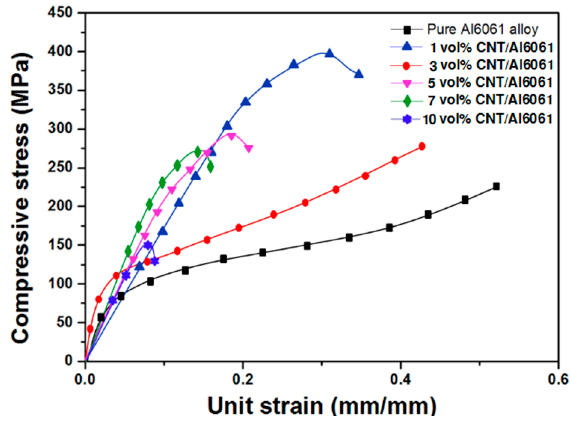
Figure 6. Compressive stress-strain curve of each material (compaction pressure: 1 GPa; sintering temperature: 620 °C).